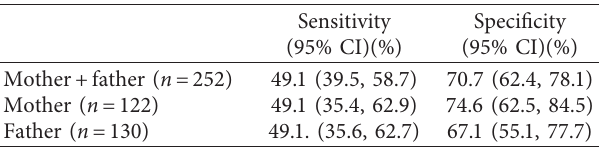
Table 6: Sensitivity and specificity for fever over 39 ° C detection by palpation.